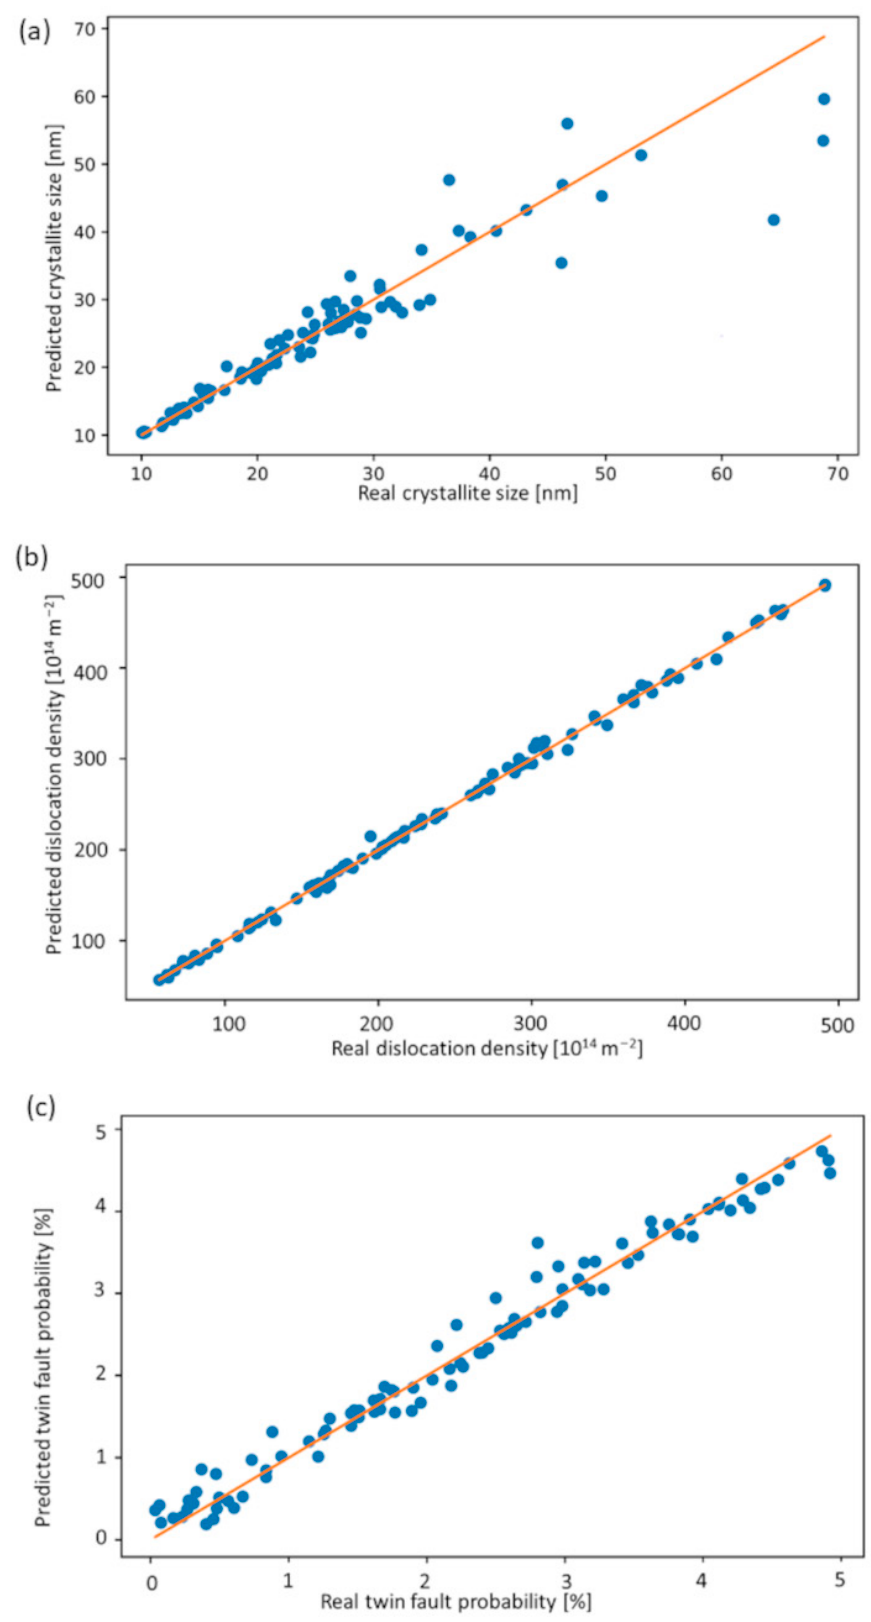
Figure 5. The real values of the crystallite size ( a ), dislocation density ( b ) and twin fault probability ( c ) versus the predicted ones obtained by ML-XLPA for the control set of diffractograms.